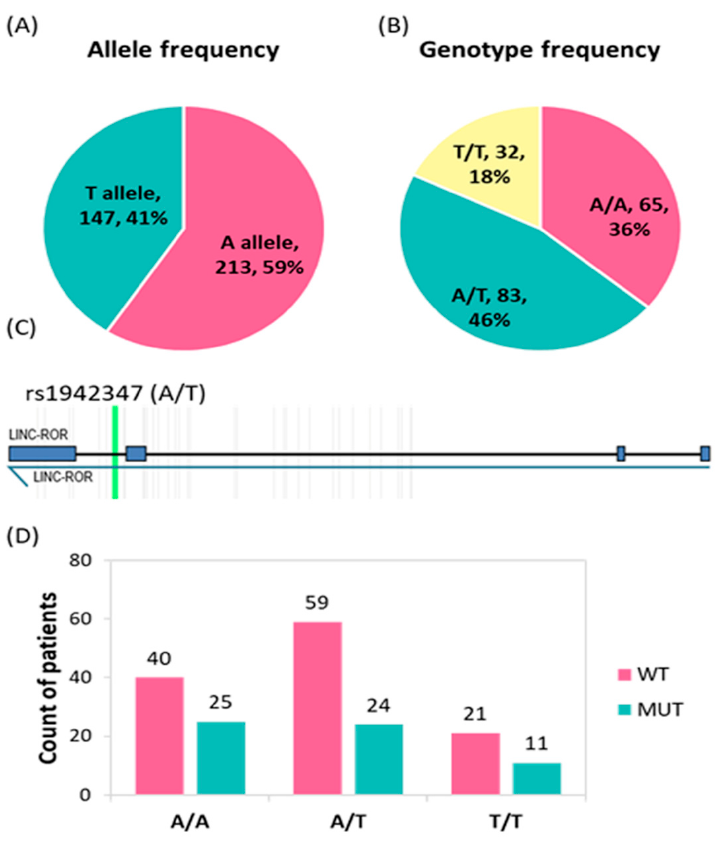
Figure 3. Genotype and allele frequencies of the LINC-ROR rs1942347 variant. Data are presented as a frequency and percentage. A two sided-Chi-square test was used. Statistical analysis was set at a p -value below 0.05. ( A ) Allele frequency of patients with CC, ( B ) Genotype frequency of 180 patients with CC. ( C ) Gene variant location within the LINC_ROR intron. ( D ) Relationship between the BRAF mutation and genotype results ( p = 0.46).